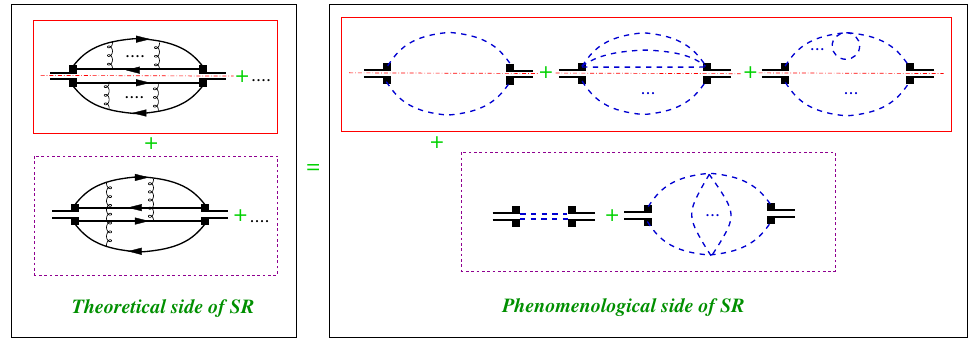
Figure 5. Aggregation of a pair of unconnected conventional-meson QCD sum rules of the kind recalled by Figure 6 (top row, separated by a red dot-dashed line) and (bottom row) the tetraquark-adequate QCD sum rule of generic structure as in Figure 7, potentially supporting tetraquark intermediate-state poles: outcome of the uncritical evaluation of correlation functions (25) still awaiting its disentanglement [30,32].